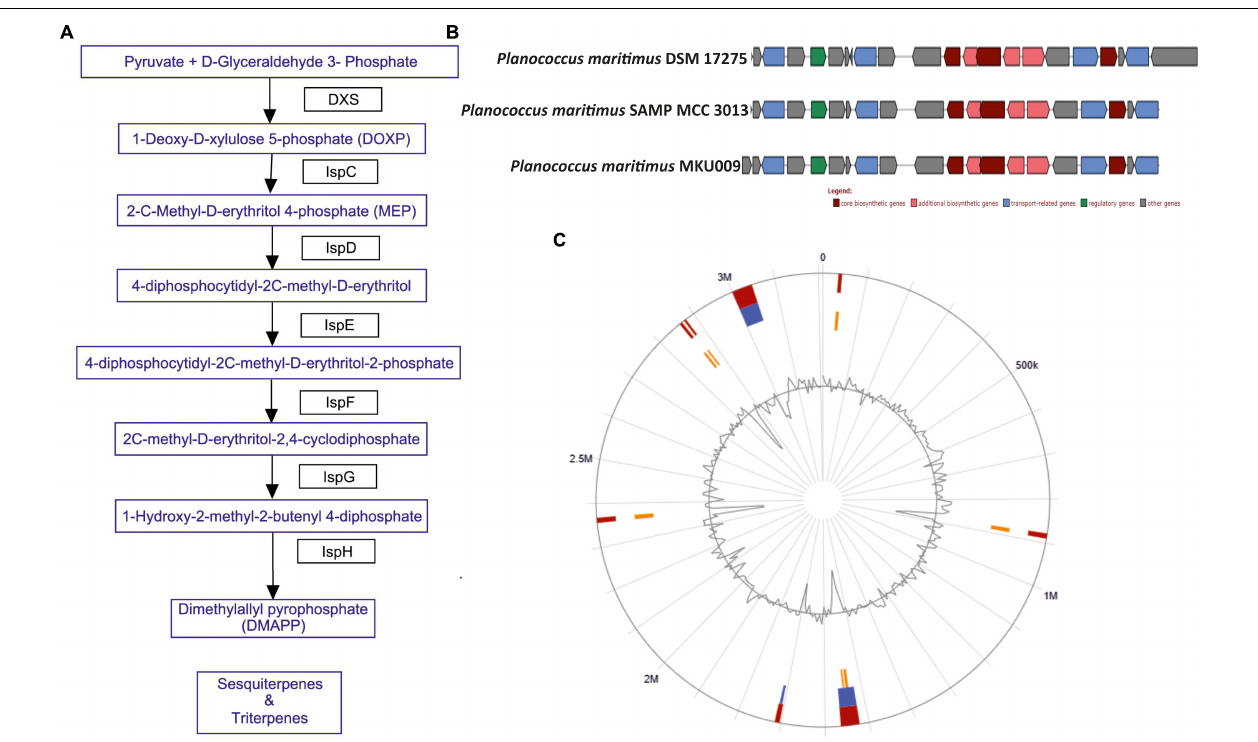
FIGURE 2 | (A) The biosynthetic pathway found in the strain P. maritimus SAMP for terpenoid production. (B) Comparison of terpene biosynthesis gene cluster with the available genomes. (C) Genomic island of SAMP. Red color defines predicted genomic islands using integrated method. The blue color shows genomic islands predicted by IslandPath-DIMOB while yellow color shows genomic islands predicted by SIGI-HMM method. The broken lines represent scaffolds